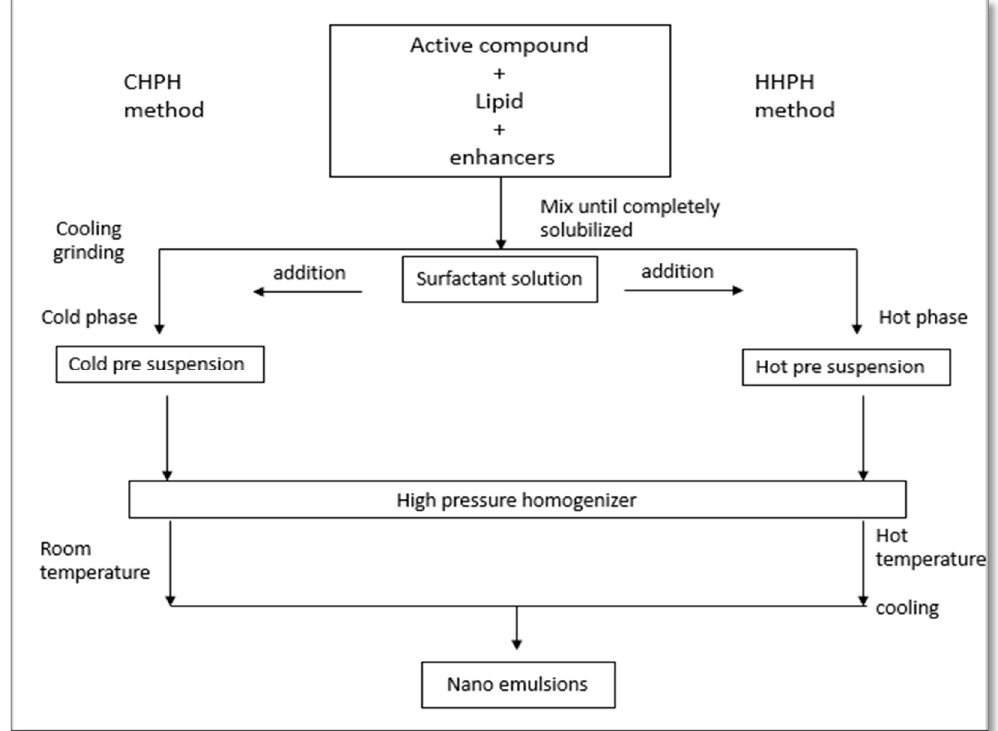
Figure 2. Summary of the NE production process using the cold and hot HPH techniques. This figure is modified & reproduced with permission from Pardeike et al. International Journal of Pharmaceutics; published by Elsevier, 2009, [32]. CHPH = cold high pressure homogenization method; HHPH = hot high pressure homogenization method.